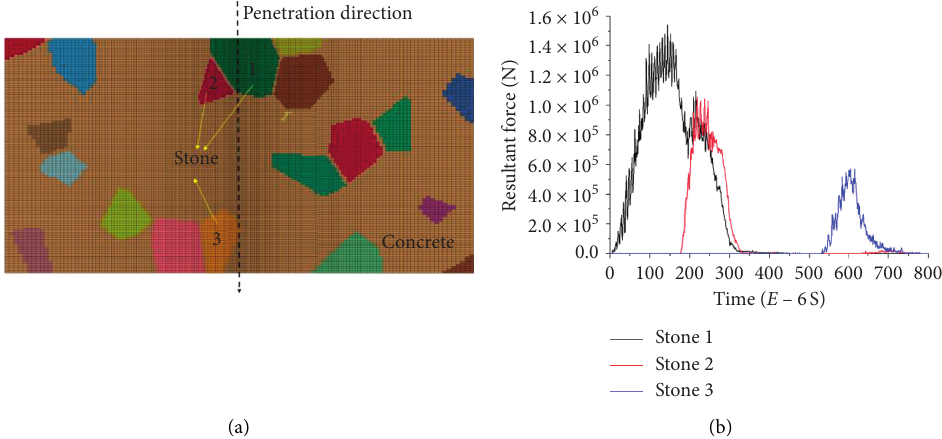
Figure 6: Contact force-time curves of stones collided by the projectile. (a) Stones numbered in the penetration path. (b) Contact force-time curves of